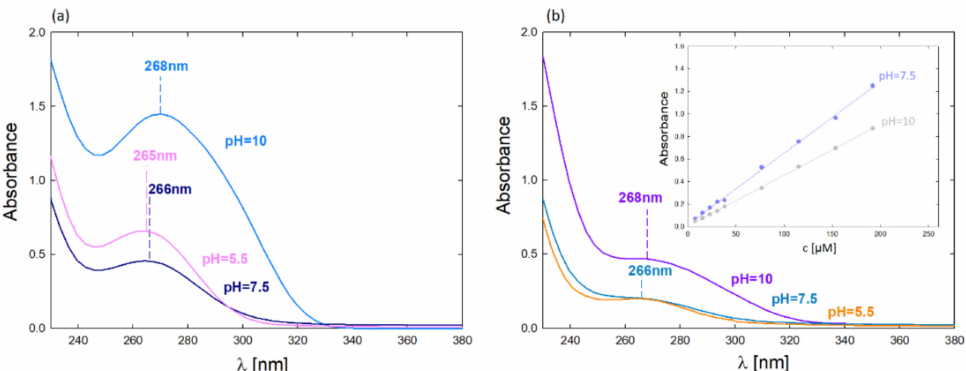
Figure 3. UV-Vis spectra of complexes after dialysis depending on the pH of complex formation (molar ratio 1:800): ( a ) G4PAMAM–5FU (c PAMAM = 17.5 µ M); ( b ) G6PAMAM–5FU (c PAMAM = 4.3 µ M); (c) calibration curves for 5FU and their dependence of